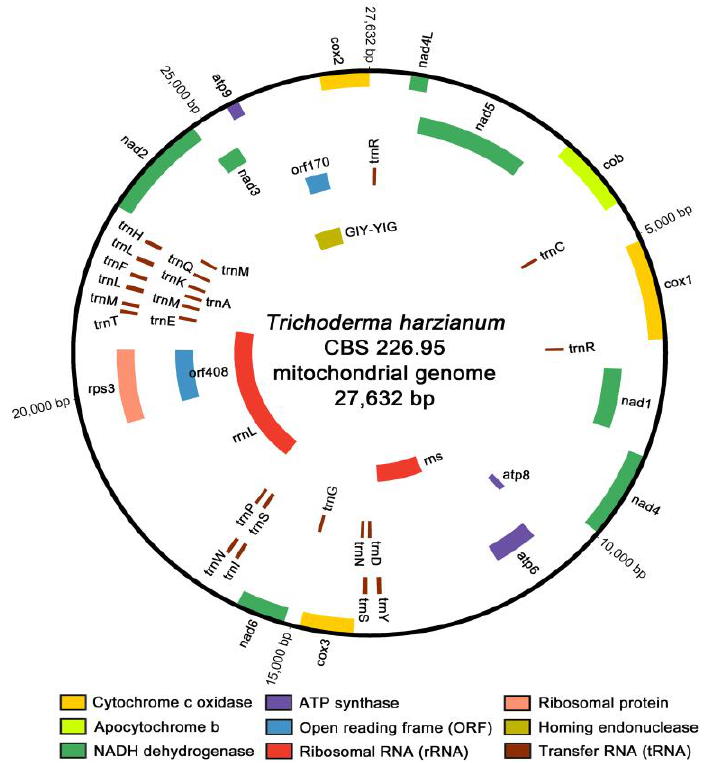
Figure 1. Circular map of the complete mitochondrial genome of T. harzianum CBS 226.95. Gene components were indicated with different color blocks, and the circular map was plotted using Circos.